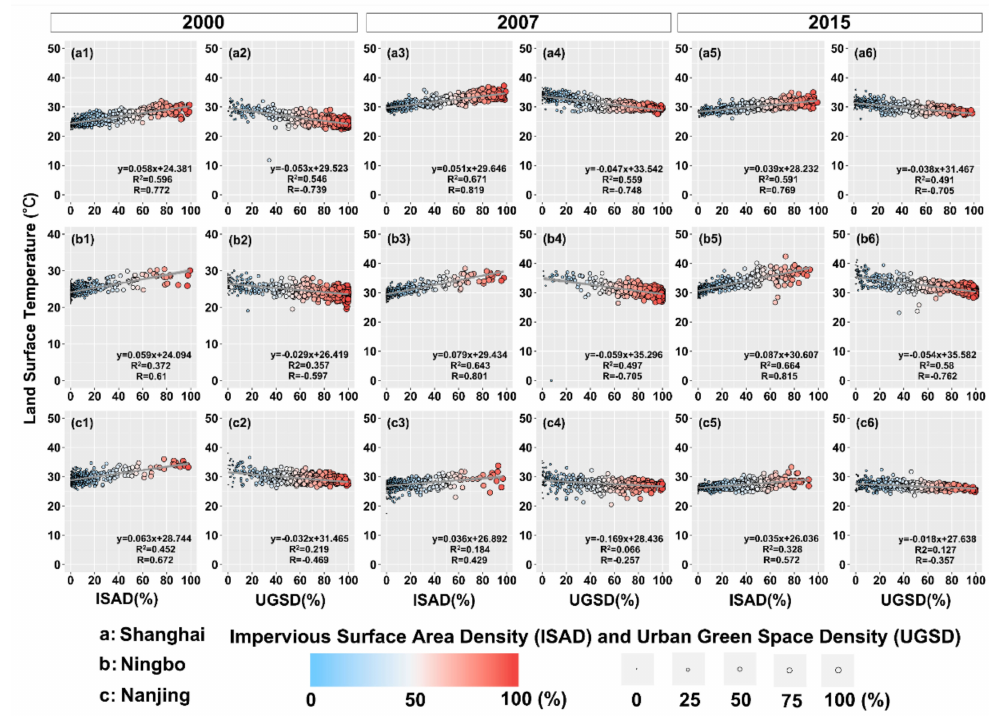
Figure 8. The relationship between the ISAD, UGSD and the LST across Shanghai, Ningbo and Nanjing from 2000 to 2015. Different colors and the size of bubbles denote the magnitude of the ISAD and